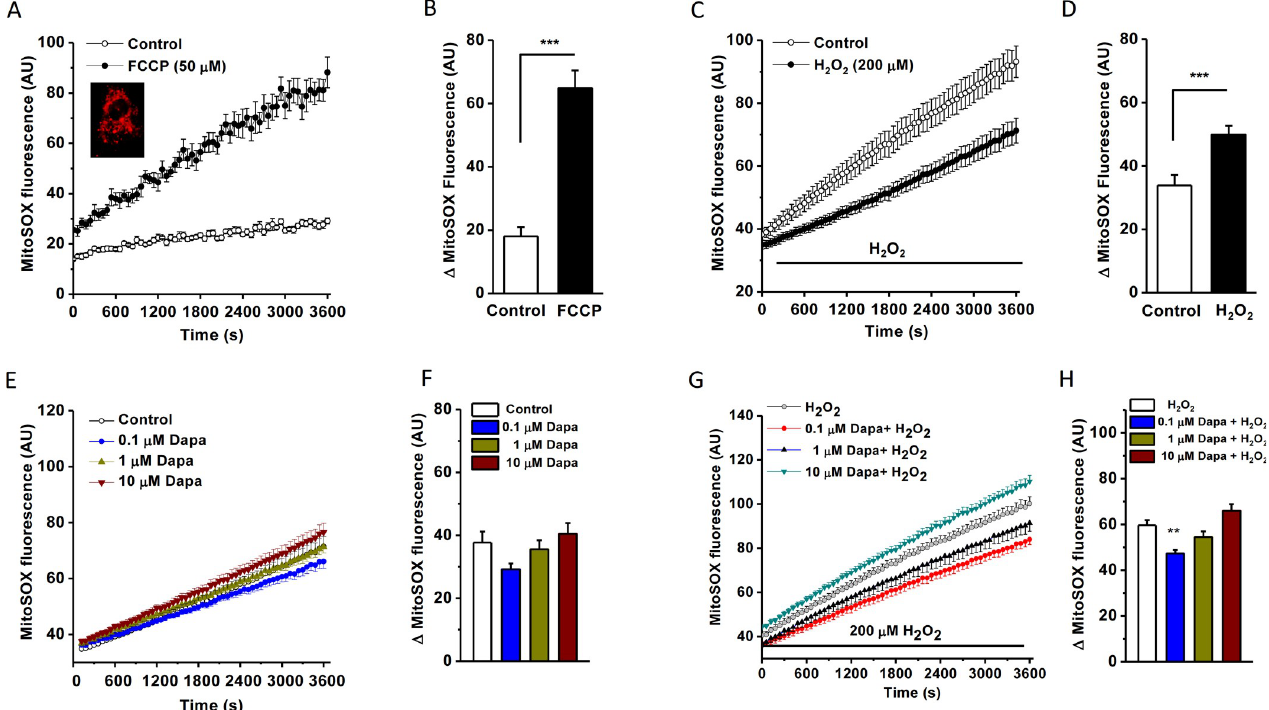
Fig 6. Mitochondrial ROS detected by MitoSOX and the effect of dapagliflozin. A. HK-2 cells loaded with mitochondrial ROS indicator MitoSOX (5 μ M) and measured by FlexStation 3 at the excitation wavelength of 510 nm and emission wavelength of 580 nm and the kinetics was sampled every 60 sec. The time course for the cells treated with FCCP (50 μ M) or without FCCP (control). Example of MitoSOX (Red) loading was shown in the inset. B. Mean data for MitoSOX intensity change at the time point of 60 min in both control and FCCP groups ( n = 8 for each group, ��� P < 0.001). C, Time course for MitoSOX fluorescence in the cells treated with or without (control) 200 μ M H 2 O 2 . D, Mean ± SEM data ( n = 7 for each group, ��� P < 0.001 assessed by unpaired t -test). E, Effect of dapagliflozin (Dapa) on the intensity of mitochondrial ROS fluorescence in HK-2 cells under normal conditions. F, Mean ± SEM data ( n = 7 for each group). G, Effect of dapagliflozin under H 2 O 2 -induced oxidative stress conditions. H, Mean ± SEM data for the delta changes of mitochondrial MitoSOX intensity within 60 min treatment ( n = 7 for each group). One-way ANOVA with Bonferroni post hoc test was used, �� P <